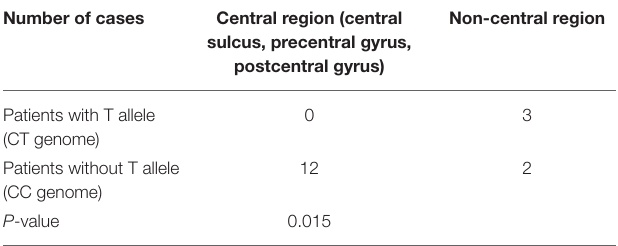
TABLE 5 | Discharge distribution and statistical analysis of the ELP4 rs662702 allele. Number of